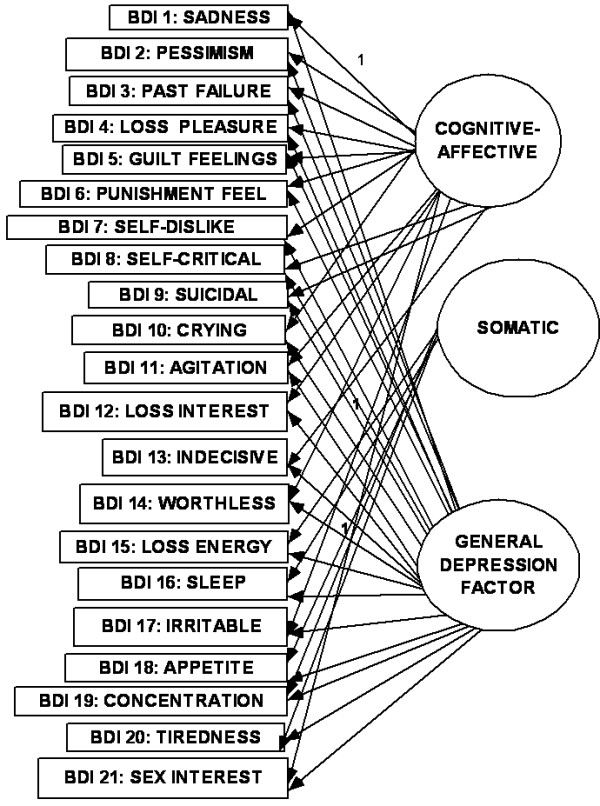
Bifactor model using CA-S model.